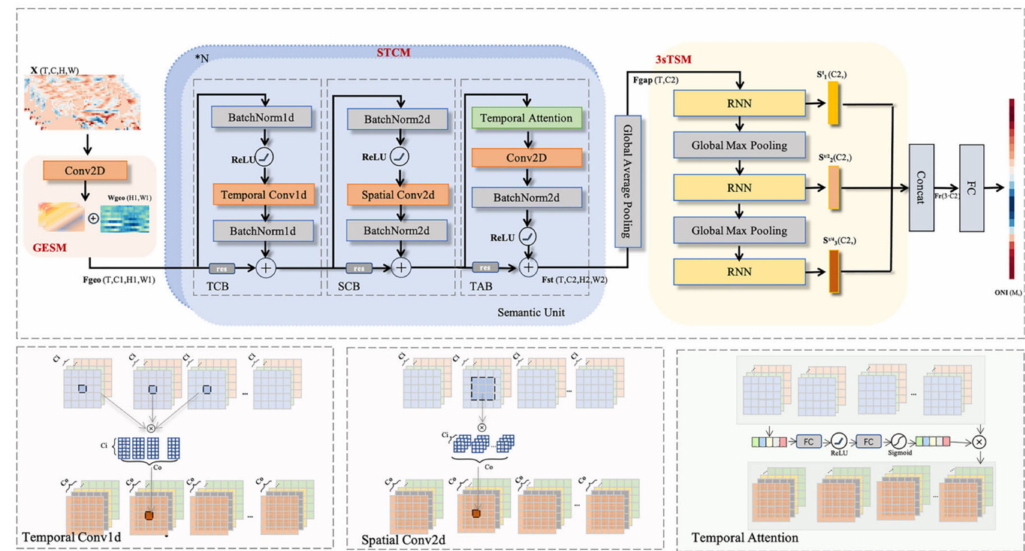
Figure 5. The pipeline of the proposed STSNet